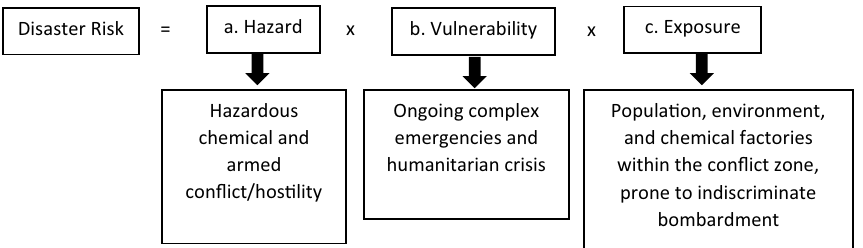
Figure 1. Conceptual framework for this disaster risk assessment adapted from UNDRR terminology and Crichet et al 14,15